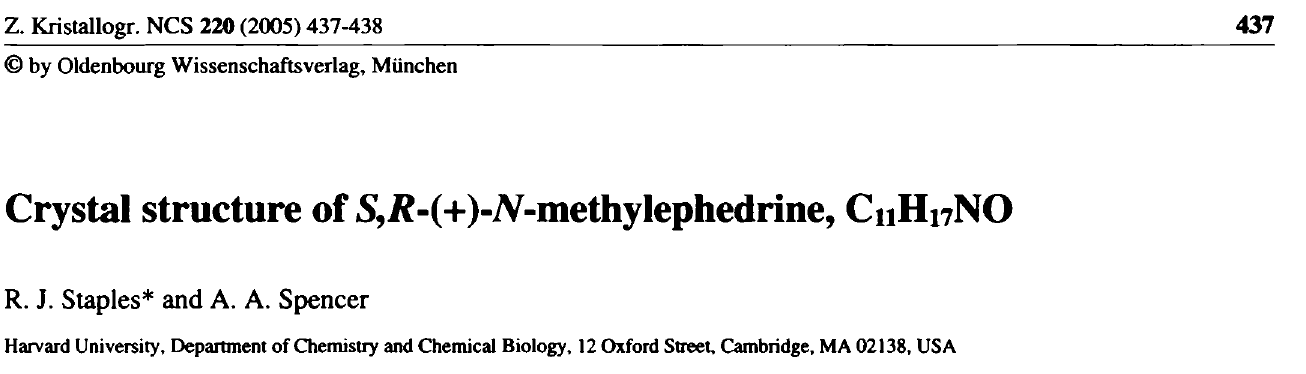
Table 1. Data collection and handling.